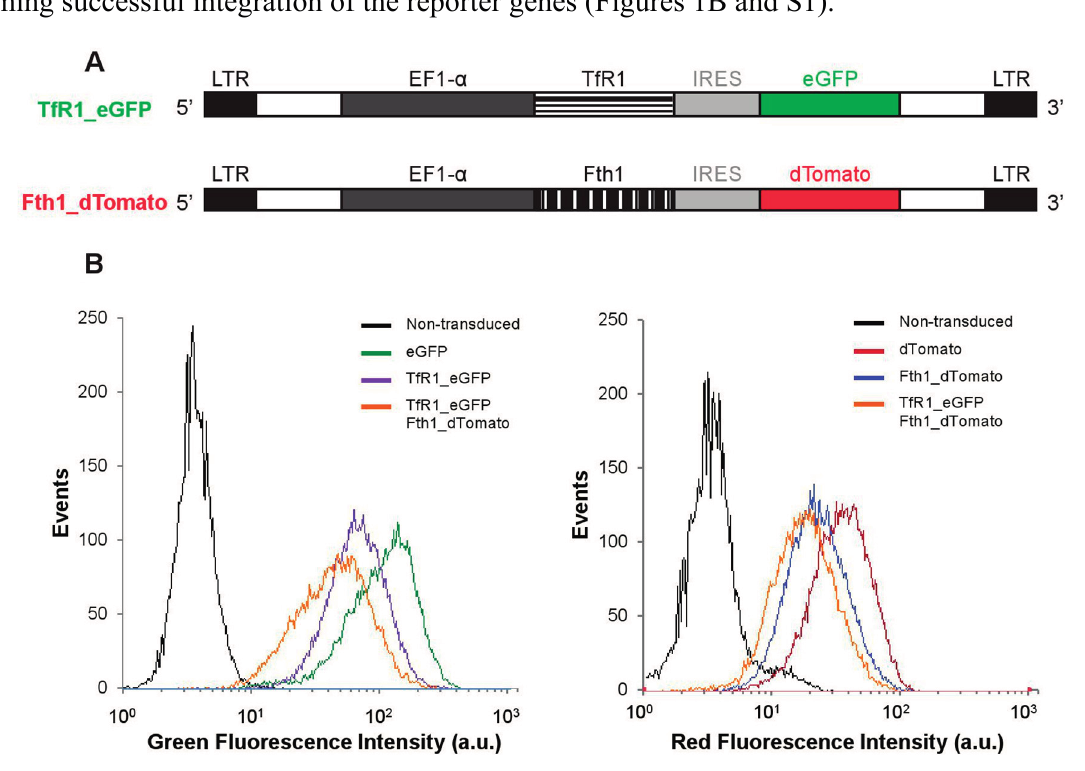
Figure 1. Reporter gene constructs and genomic integration in MSCs. ( A ) Schematic representation of each of the constructs. LTR: long terminal repeat; EF1- α : Elongation factor 1 alpha; ( B ) Fluorescence histograms obtained via flow cytometry showing successful integration of the